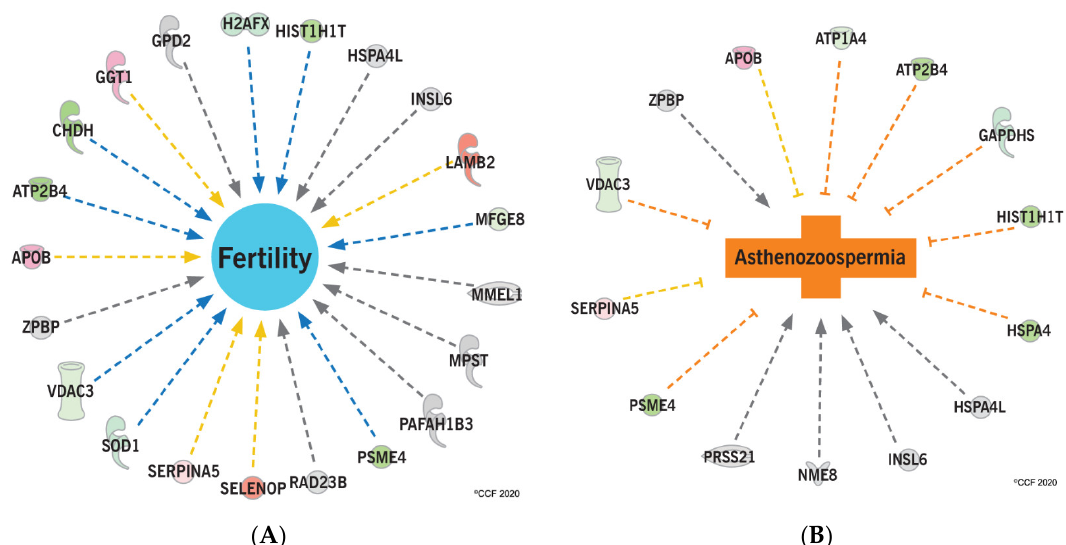
Figure 5. Differentially expressed proteins associated with ( A ) fertility potential and ( B ) motility of sperm in the cancer group in comparison with fertile men.